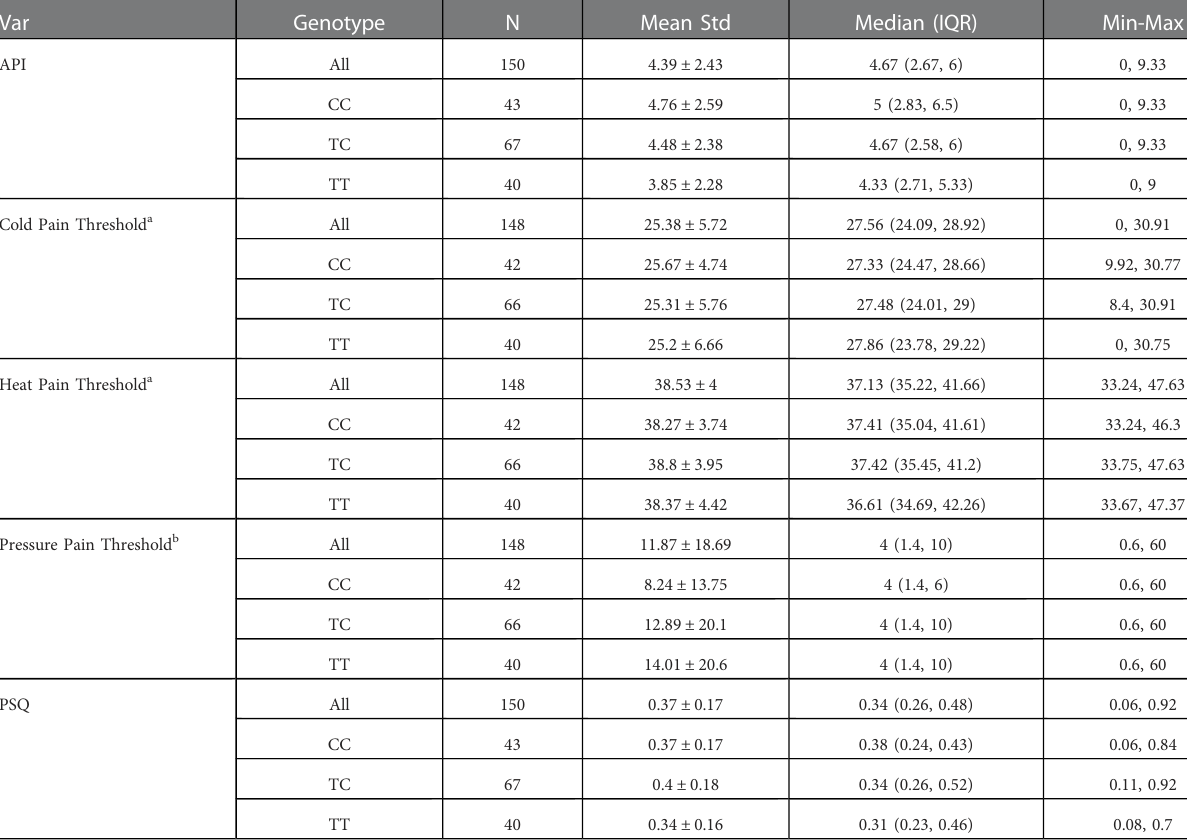
TABLE 2 Mean and standard deviation of variables with rs10877969 genotype.